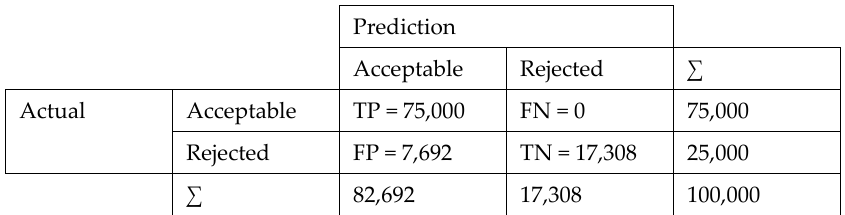
Figure 6. Confusion matrix for k ‐ nearest neighbors (kNN).